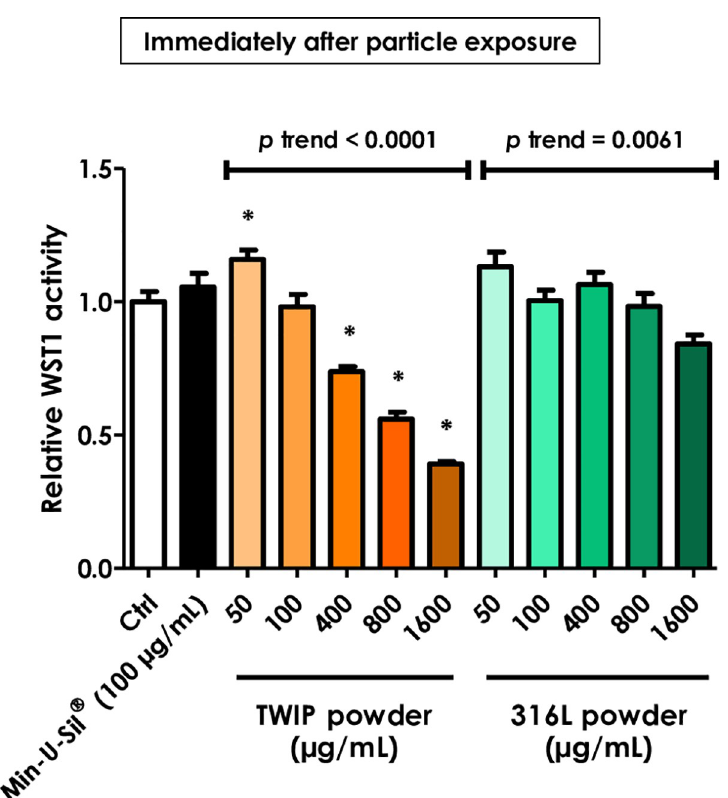
Fig 4. The WST-1 assay falsely indicates that HUVECs are dose-dependently affected by direct exposure to TWIP steel particles. HUVECs were grown in 96-well transparent or white plates and exposed the next day to different suspensions of TWIP steel or 316L steel powders. WST-1 activity was measured immediately after exposure without washing and recorded as shown in Fig 3. Min-U-Sil 1 was used as positive control. Values are means ± SEM (n = 4), � p < 0.05 relative to control (One-way ANOVA followed by a Dunnett’s multiple comparison). The trend test included controls.